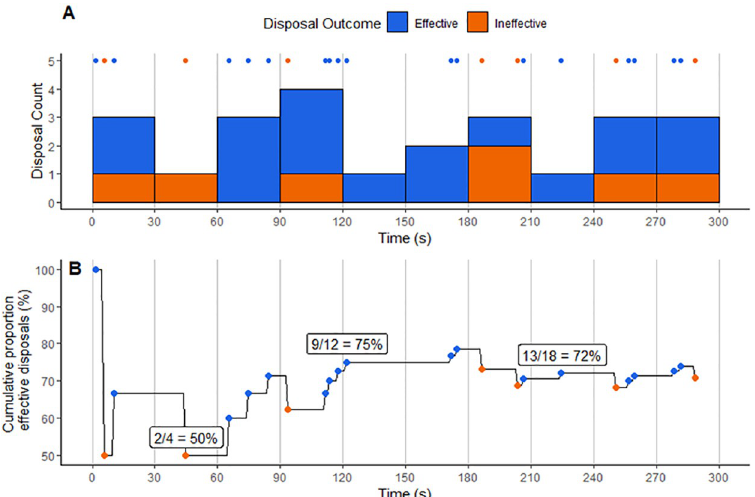
Fig 1. Example from a single activity repetition displaying disposal efficiency represented in 30 s bins (A) and continuously (B). Effective and ineffective disposal events are represented by the points. Three periodic annotations are provided to help describe the sequence calculation in panel